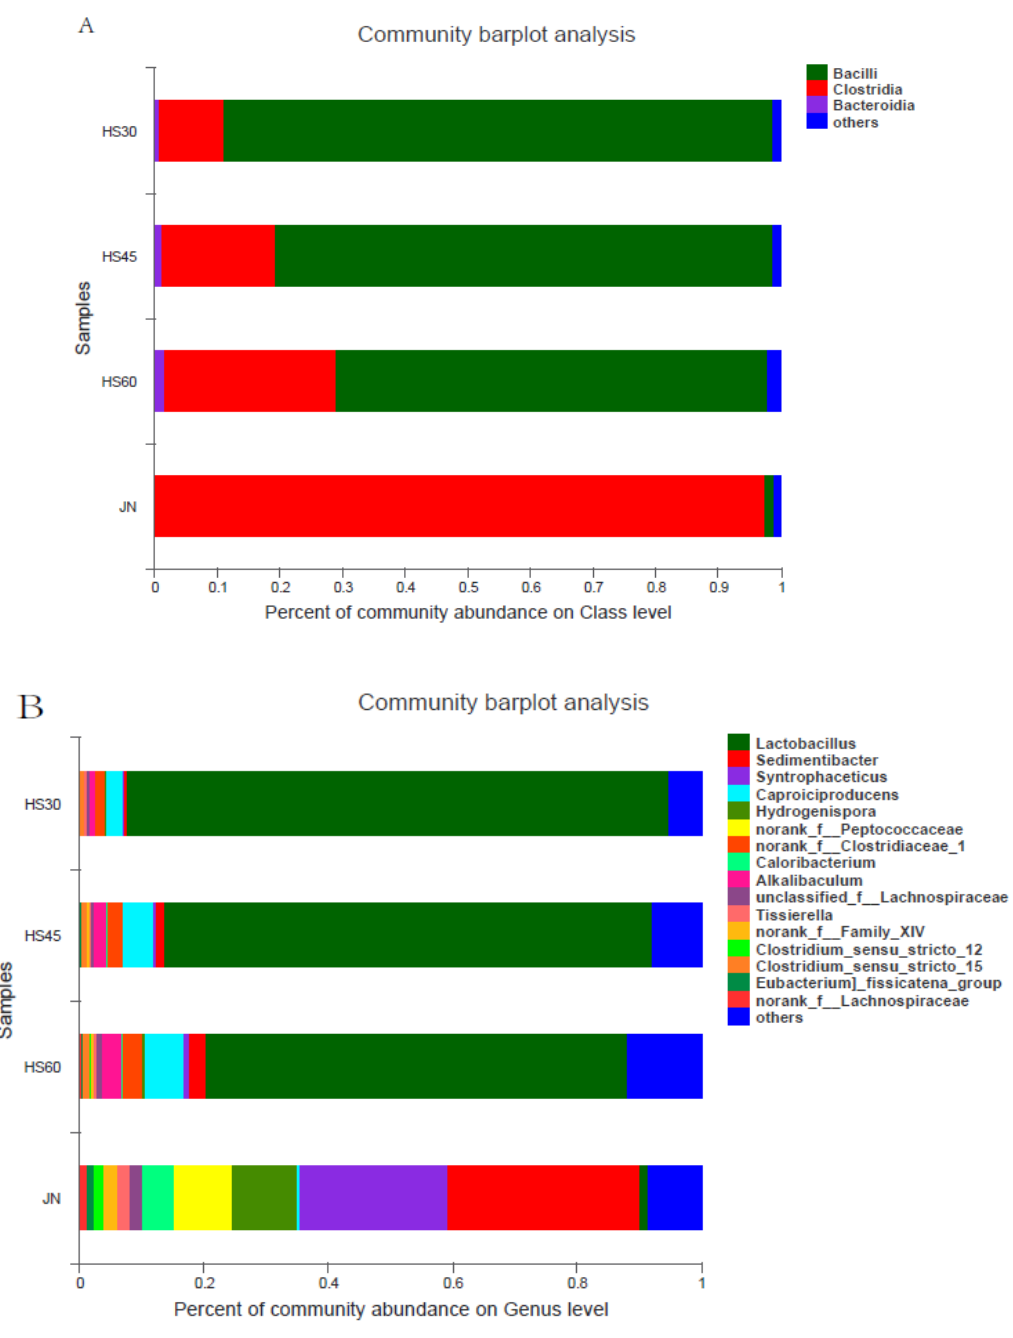
Figure 3. Percent of community abundance. ( A ) Percentage of community abundance at the class level; ( B ) Percentage of community abundance at the genus level. HS30: yellow water on the 30th day, HS45: yellow water on the 45th day, HS60: yellow water on the 60th day, JN: pit mud.